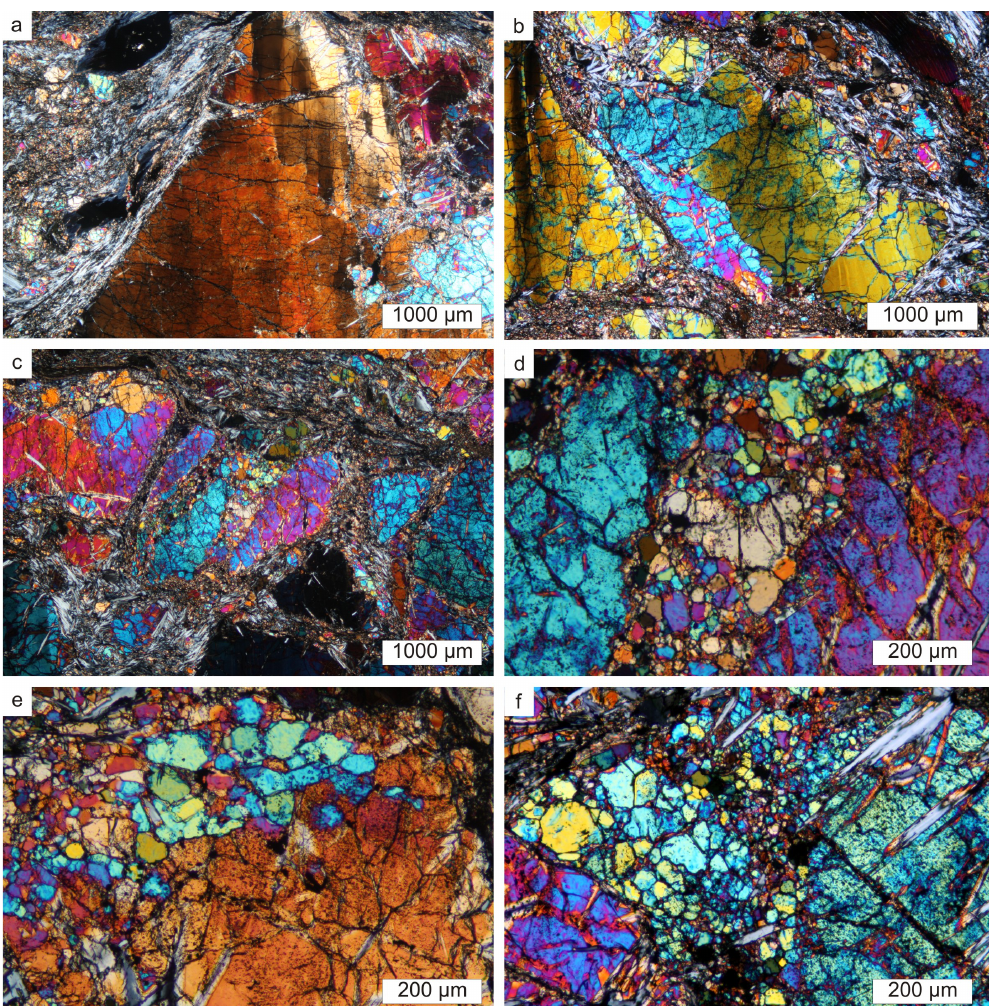
Fig. 3. Polarized light micrograph (crossed polarizers) showing microstructures in olivine porphyroclasts from sample CT_07-13. (a, b) Deformation bands and subgrains in olivine porphyroclasts; (c, d) intragranular zones of recrystallized olivine grains within olivine porphy- roclast; (e, f) partly recrystallized olivine porphyroclasts. EBSD map of area in f is presented in Fig.